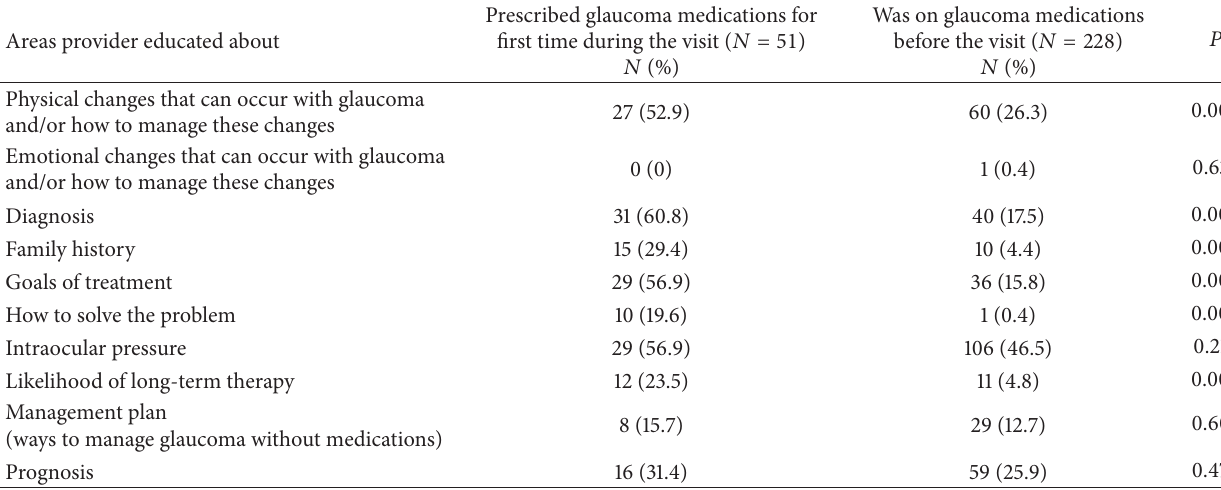
Table 3: Provider educates the patients about glaucoma by whether patients are prescribed glaucoma medications for the first time or if they were on them before the visit ( 𝑁 = 279